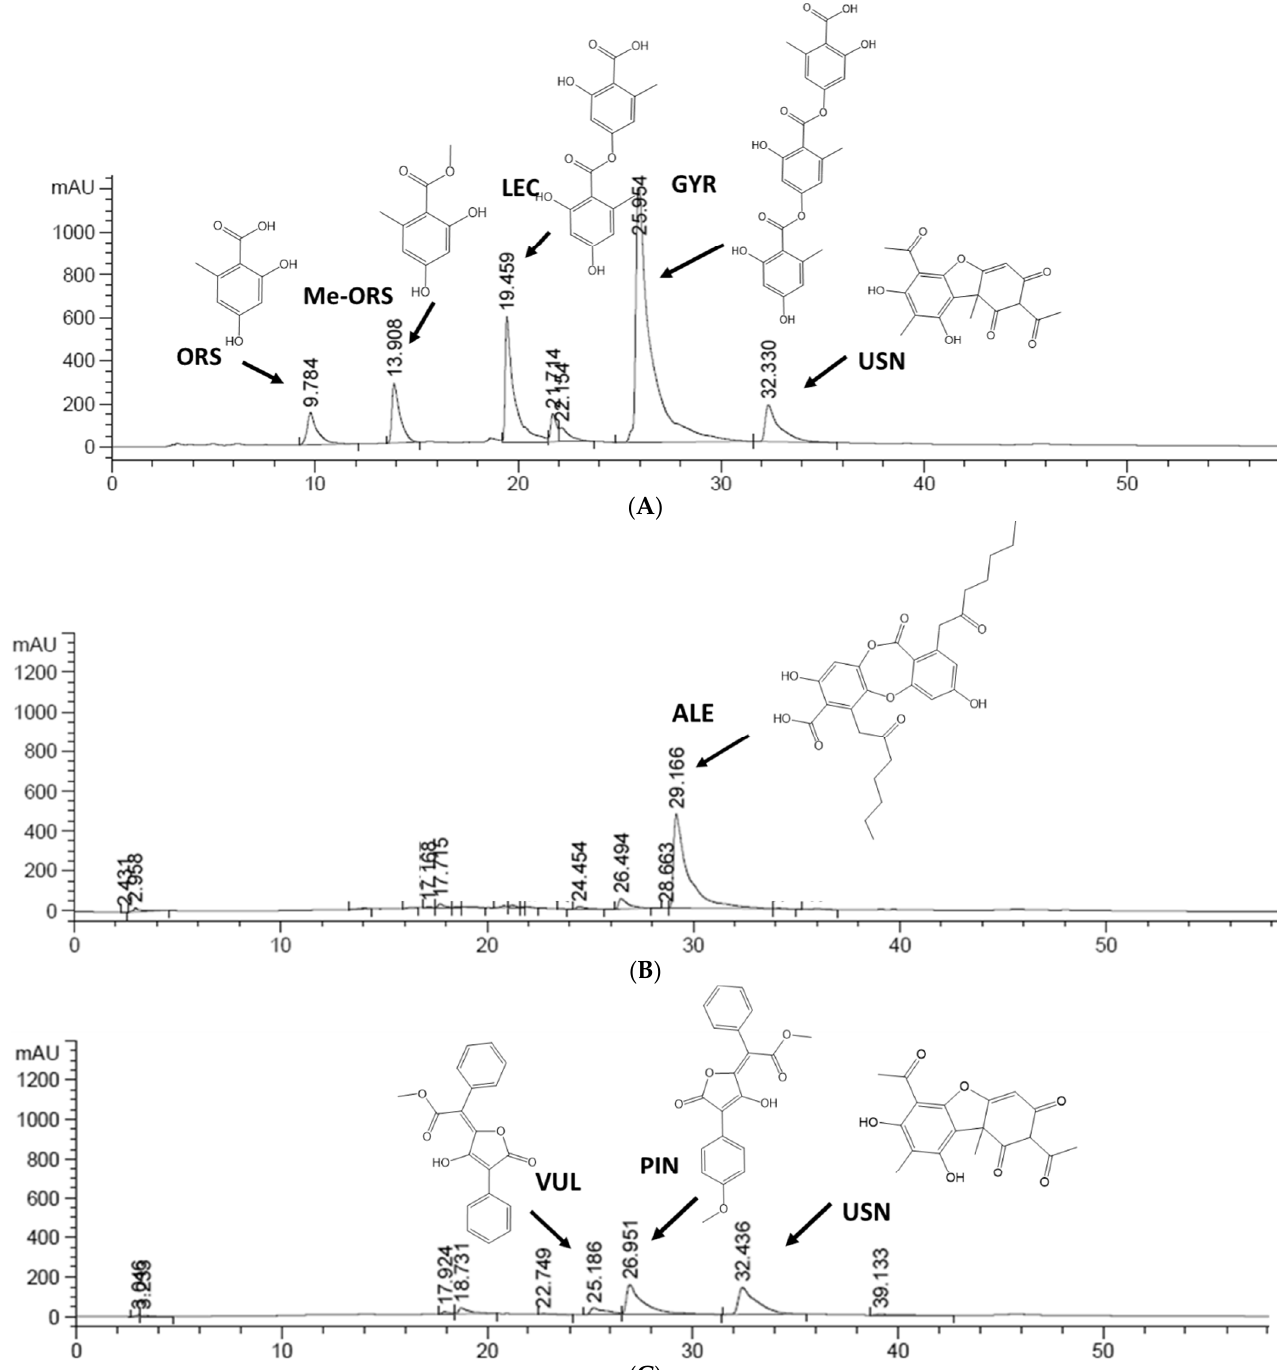
Figure 6. Representative HPLC chromatograms ( λ = 254 nm) ( A ) Dactylina artica ( B ) Tuckermannopsis americana ( C ) Vulpicida pinastri.